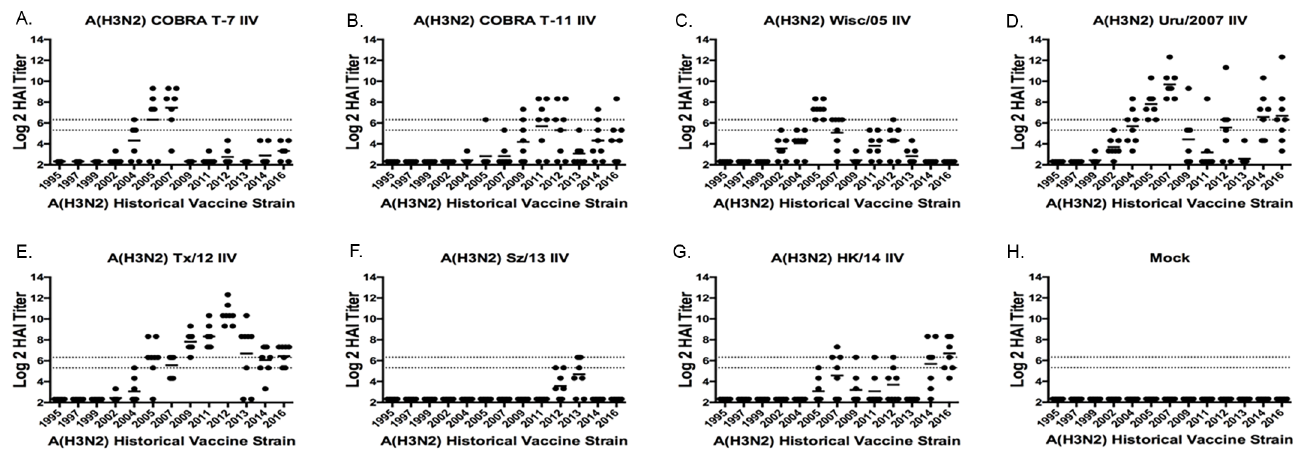
Fig 2. Hemagglutination inhibition serum antibody titers induced by vaccination of ferrets with H3N2 IIV vaccines expressing COBRA HA antigens or HA proteins from wild-type viruses. HAI titers were determined for each group of immunologically naïve ferrets (n = 8) vaccinated two times (days 0 and 28) with 1 of the 2 COBRA H3N2 IIV vaccines (T7 or T11) or H3N2 VLP vaccines expressing wild-type HA proteins from Wisc/05, Uru/07, TX/12, Sz/13, HK/14 against a panel of 13 H3N2 influenza viruses. Values are the individual animal HAI titers from antisera collected on day 56. The two dotted lines indicates the 1:40–1:80 HAI titer range. (A) T6 IIV; (B) T11 IIV; (C) Wisc/05 IIV; (D) Uru/07 IIV; (E) TX/12 IIV; (F) Sz/13 IIV; (G) HK/14 IIV; (H)